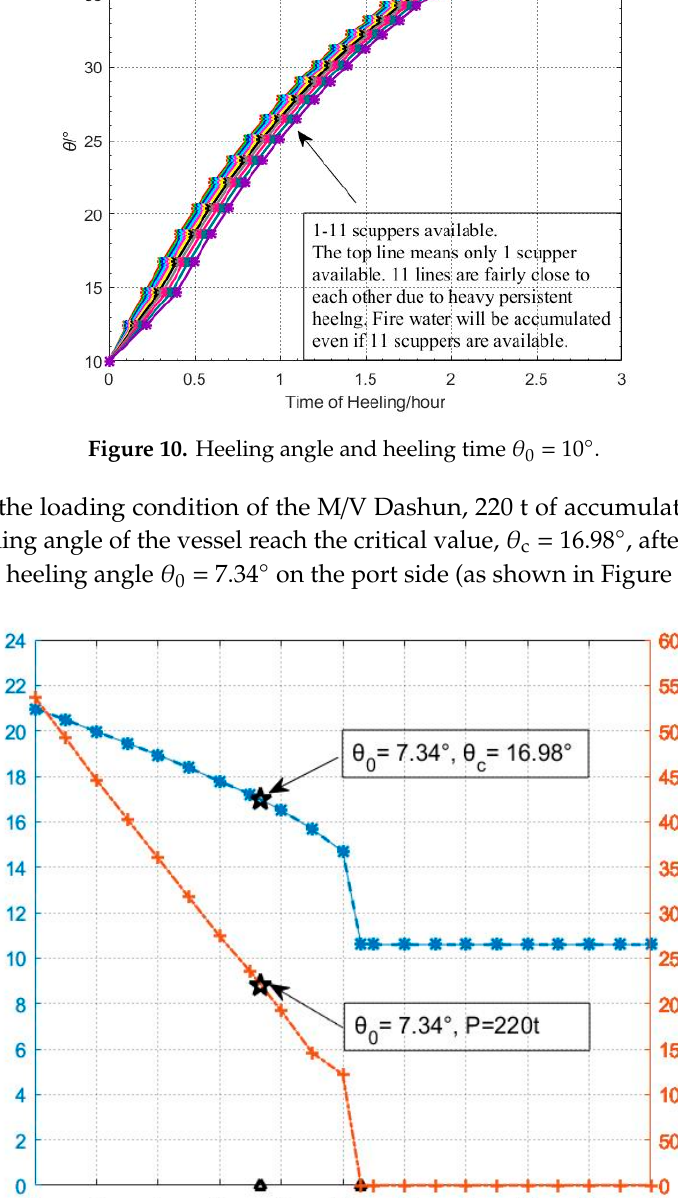
Figure 11. Critical heeling angle, θ c , and the corresponding firewater weight, P .